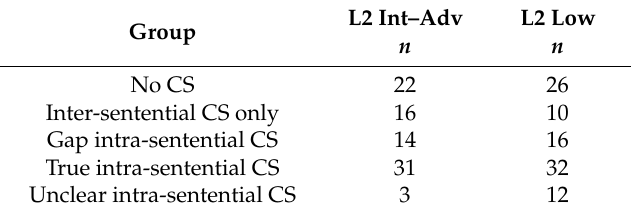
Table 2. Participants by bilingual language behavior and L2